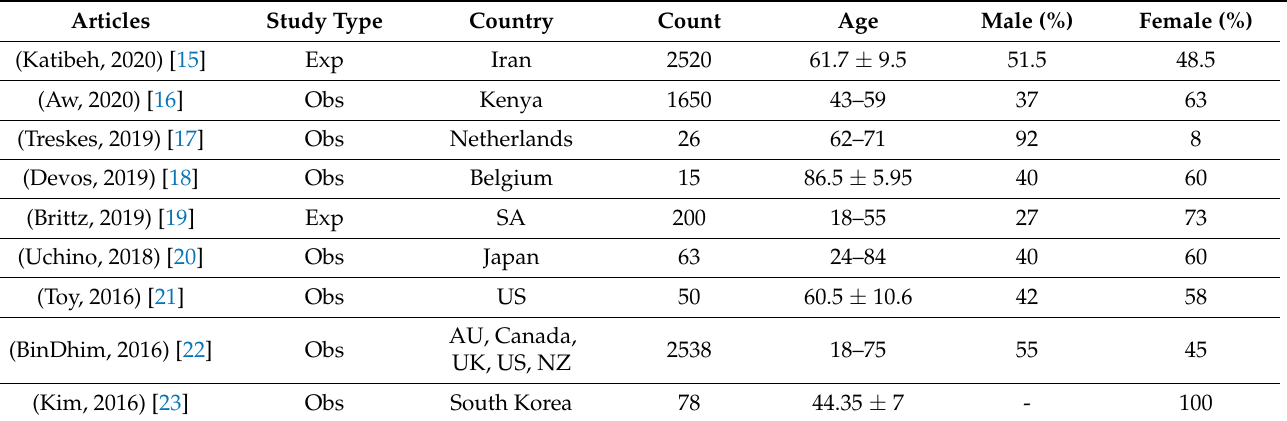
Table 2. Details of the included studies.